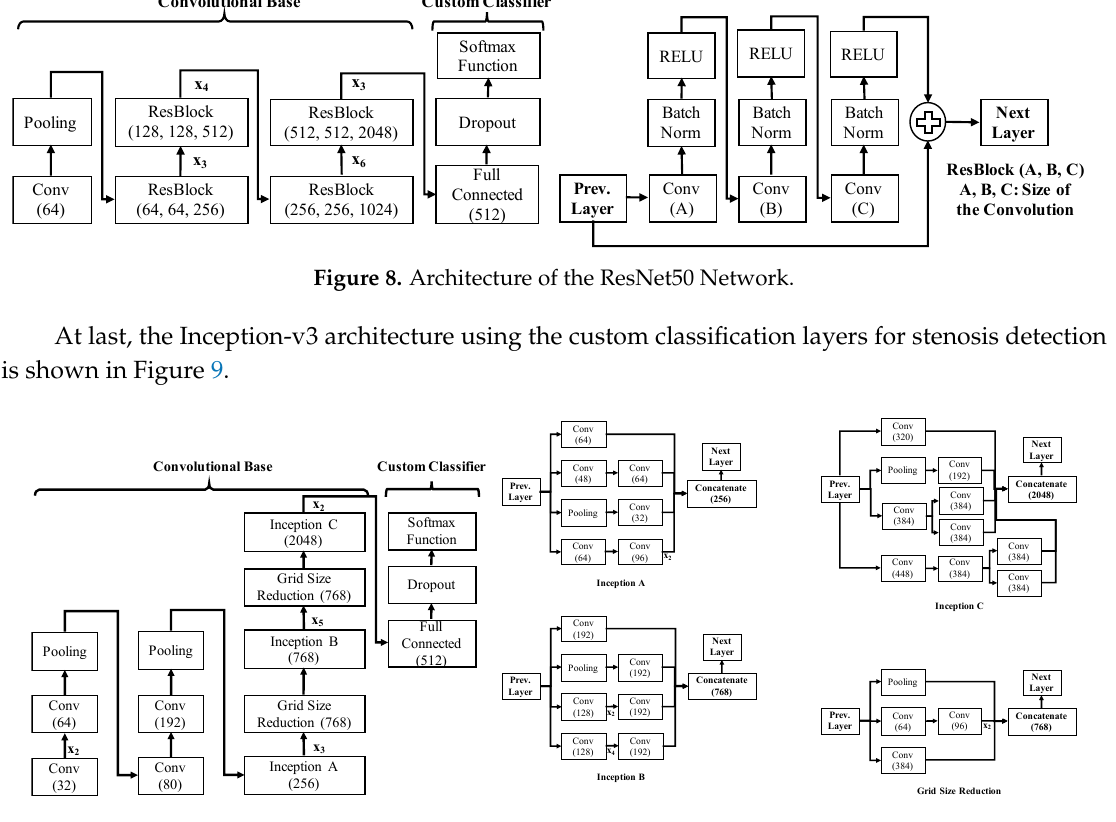
Figure 9. Architecture of the Inception-v3 Network.